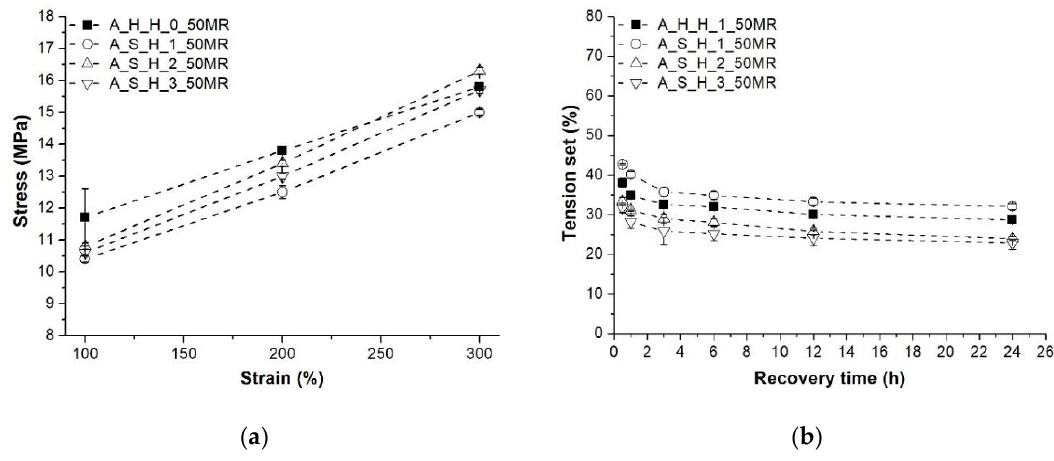
Figure 7. Stress at 100%, 200% and 300% elongation and the tension set of the TDVs produced with different PP feeding methods: ( a ) Stress; ( b ) Tension set.